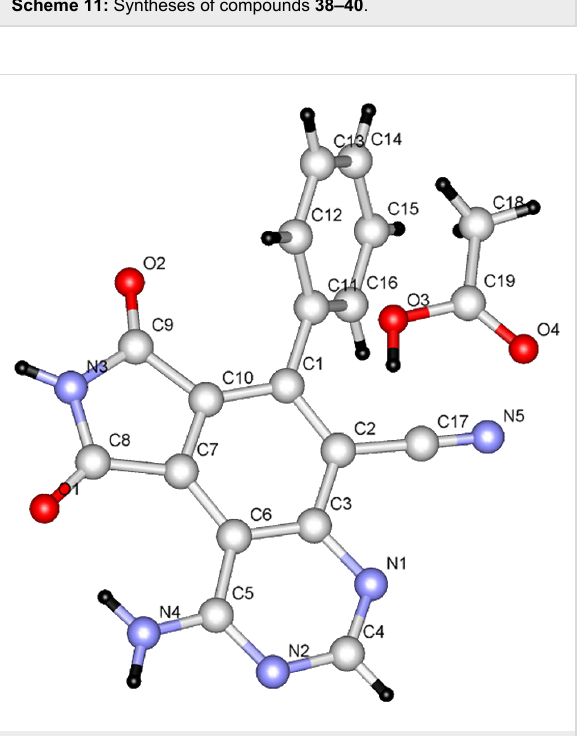
Figure 13: X-ray crystal structure of 39 .